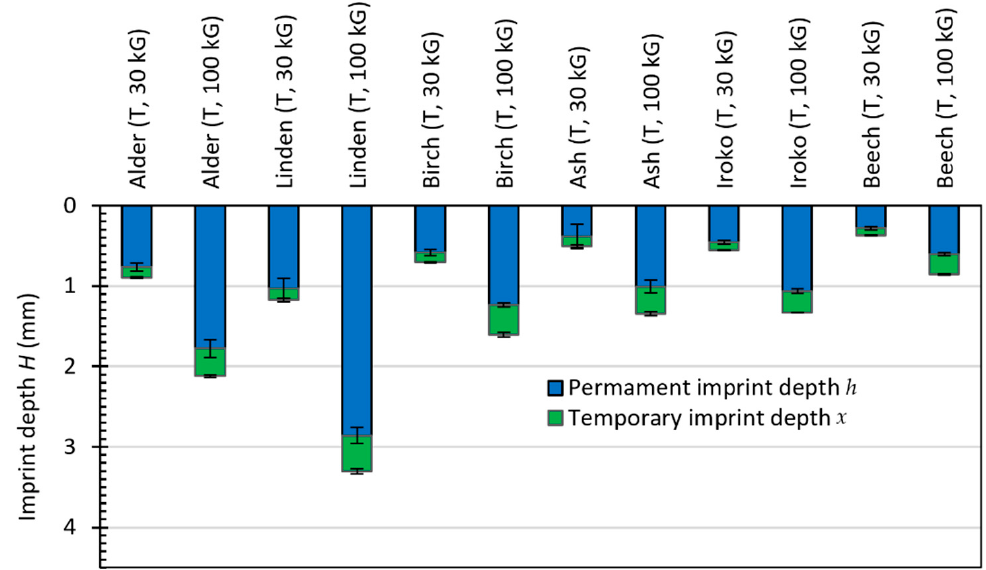
Figure 8. Imprint depth under measuring load (tangential direction).